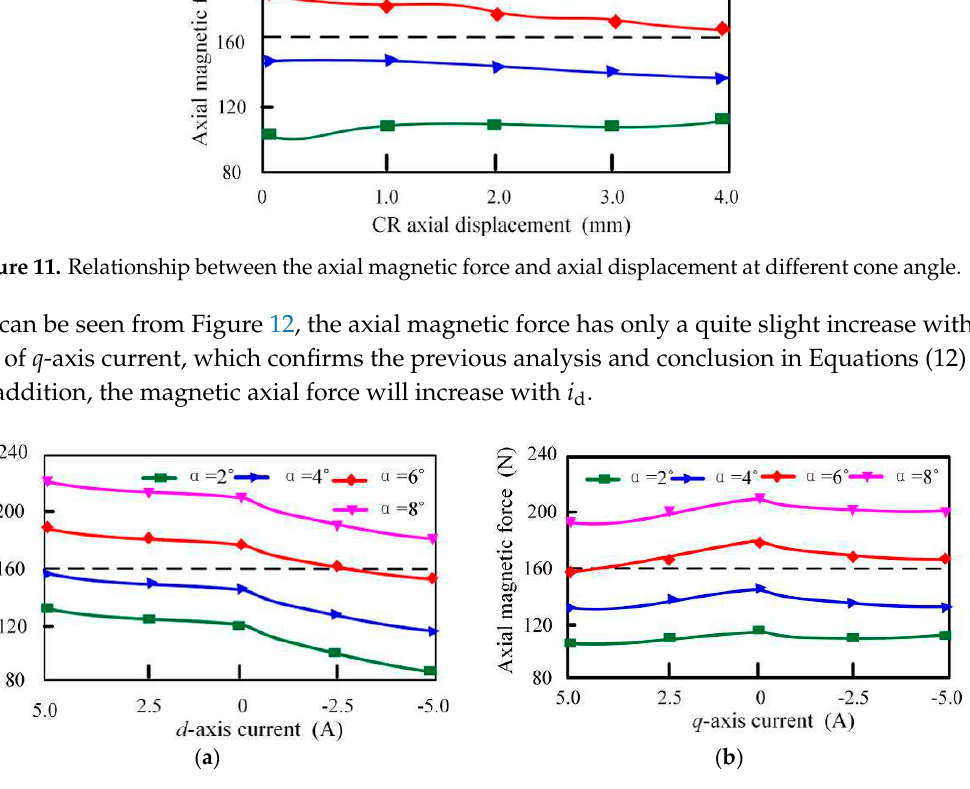
Figure 12. Relationship between the axial magnetic force and ( a ) d -axial current at different cone angle ( b ) q -axial current at different cone angle.